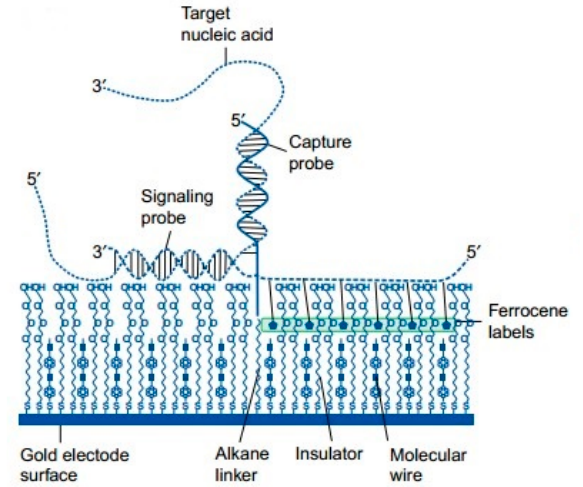
Figure 11. Scheme of the sandwich assay for electronic detection of nucleic acids. The gold electrode was coated with a SAM including (1) DNA-alkanethiols that contain the capture probe sequence, (2) molecular wires, which provide a pathway for electron transfer between the Fc and the gold in response to potential changes at the electrode. and (3) alkanethiols terminated in polyethylene glycol insulator, which serve as insulators to block access of redox species in solution to the electrode, including free signaling probes. A target nucleic acid is shown annealed to a capture probe and a Fc- labeled signaling probe [106]. Copyright Reproduced with permission from American Society for Investigative Pathology and the Association for Molecular Pathology.